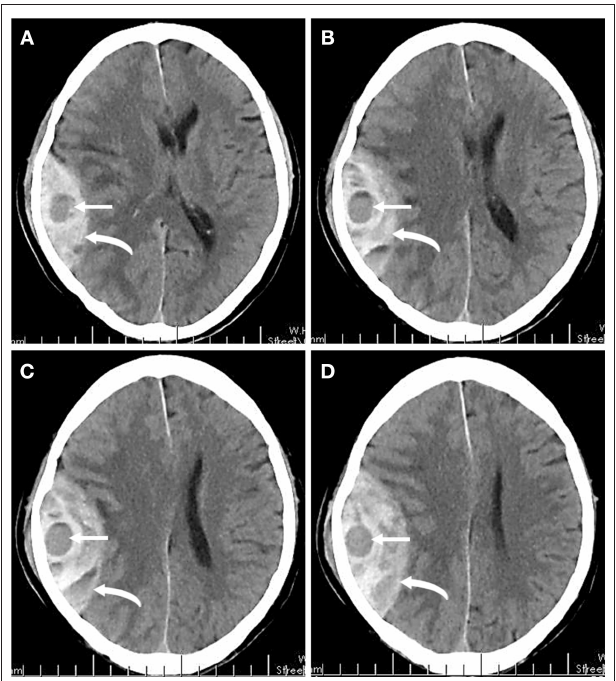
FIGURE 1 | (A–D) A series of non-enhanced brain CT images of one patient at 2h after head trauma. Right temporoparietal hyperattenuating epidural hematoma (curved arrows) with local hypoattenuating (straight arrows) represents the swirl sign.